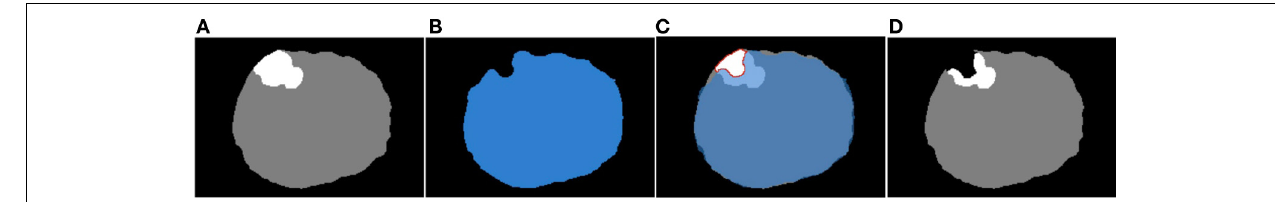
FIGURE 2 | The correction of the warped pre-op segmented MRI. (A) Input warped pre-op segmented MRI. (B) Input intra-op mask MRI. (C) The (A) and (B) overlapped. (D) Output corrected warped pre-op segmented MRI at ith